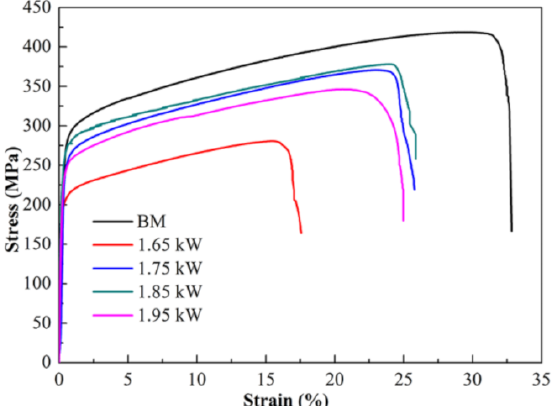
Figure 13. Stress–strain curve of the BM and welded